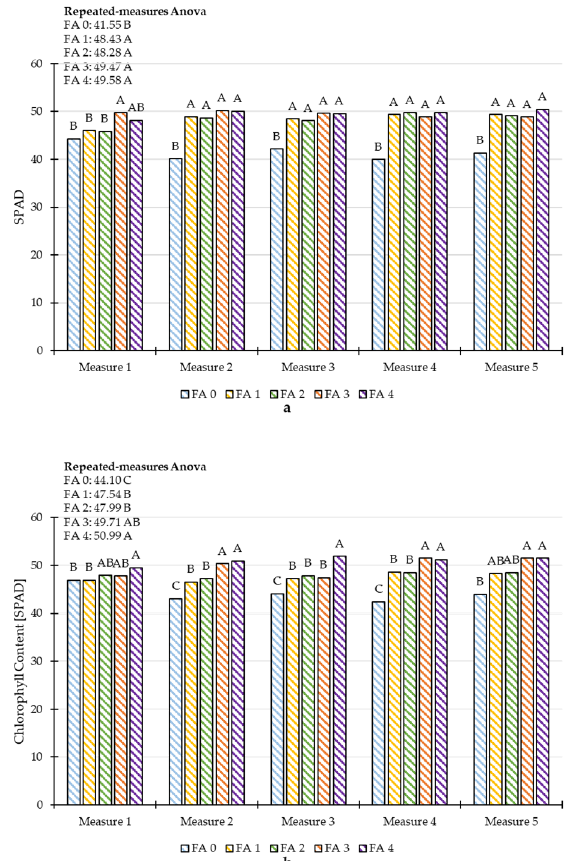
Figure 9. Chlorophyll content (SPAD) in 2020 ( a ) and 2021 ( b ). FA0: only water; FA1: 8 g L − 1 of CaO; FA2: 12 g L − 1 of CaO; FA3: 8 g L − 1 of CaO + 16 g L − 1 of urea; FA4: 12 g L − 1 of CaO + 16 g L − 1 of urea. n.s.= not significant. Values with different letters are significantly different at p ≤ 0.05 according to Tukey’s test.